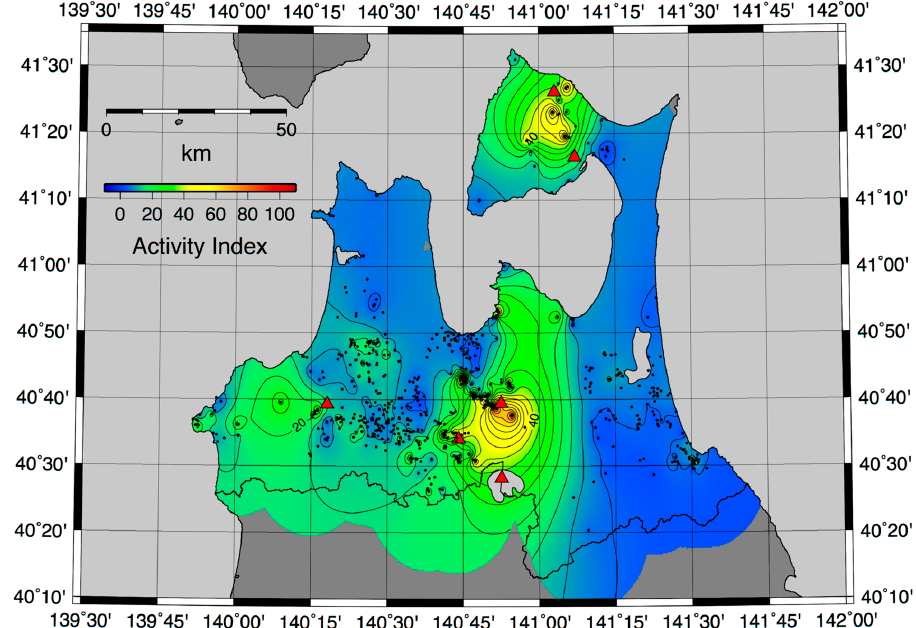
Figure 2. Activity index distribution map. Black dots indicate the data locations and red triangles indicate the locations of major Quaternary volcanoes and calderas.